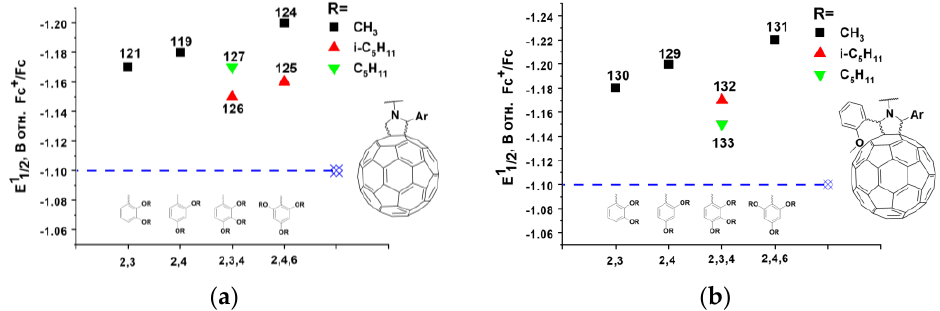
Figure 14. Dependence of E 11/2 in solution on the position of the alkoxy substituents in the phenyl rings of ( a ) 2-arylsubstituted and ( b ) 2,5-diarylsubstituted pyrrolidinofullerenes. rings of ( a ) 2-arylsubstituted and ( b ) 2,5-diarylsubstituted